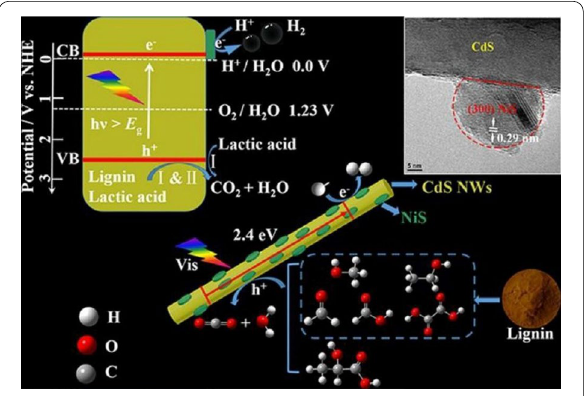
Fig. 8 a The schematic illustration of the photocatalytic hydrogen production with lignin and lactic acid over NiS/CdS nanocomposites under visible light illumination. Reprinted with the permission from Li et al. [50] (Copyright 2018